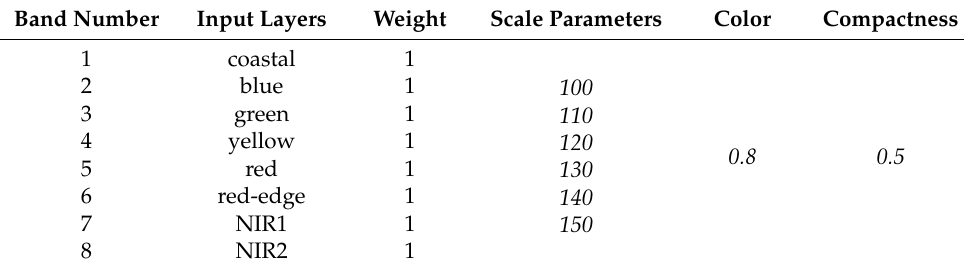
Table 3. Parameters for pan-sharpened WV2/WV3 image